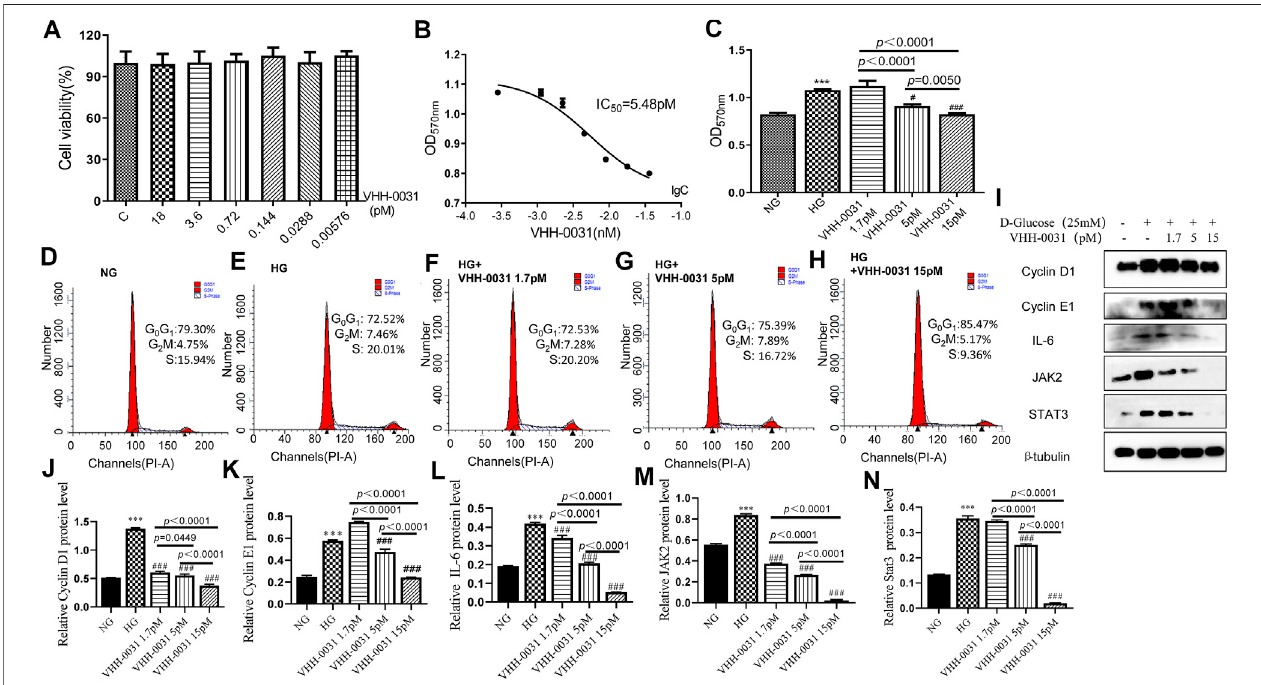
FIGURE 5 | VHH-0031 prevents proliferation of mesangial cells under high glucose condition via JAK2/STAT3 pathway (A) MTT method was performed to measure the cell viability after incubation of different doses of VHH-0031 (0 ∼ 18pM) in condition of normal glucose (NG, 5.5 mM D-glucose) (B,C) Detection of cell proliferation by MTT. Cells cycle were measured by fl ow cytometry. Cells were treated with (D) normal glucose (NG, 5.5 mM D-glucose) (E) high glucose (HG, 25 mM D-glucose),or (F – H) highglucose(HG,25 mMD-glucose)inthepresenceofVHH-0031(1.7,5,and15 pM)for48 h(I)Westernblotwereemployedtodetectedthe proteinofCyclinD1,CyclinE1,IL-6,JAK2andSTAT3.QuantitativeanalysisofCyclinD1 (J) ,CyclinE1 (K) ,IL-6 (L) ,JAK2 (M) ,andSTAT3 (N) inHBZY-1.*** p < 0.001 vs NG group. ### p < 0.001 vs HG